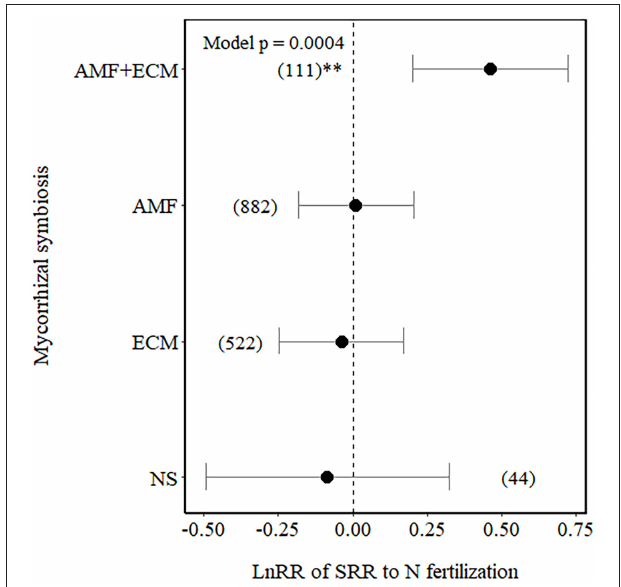
FIGURE 2 | Effect sizes (LnRR) of specific root respiration (SRR) to N fertilisation in plants with no mycorrhizal associations (NM), with ectomycorrhizal associations (ECM) only, arbuscular mycorrhizal associations (AM) only, or AM + ECM associations. Numbers in brackets represent the number of observations, and error bars represent the 95% CIs. **indicates significance at p < 0.01. Only observations from field experiments are included.